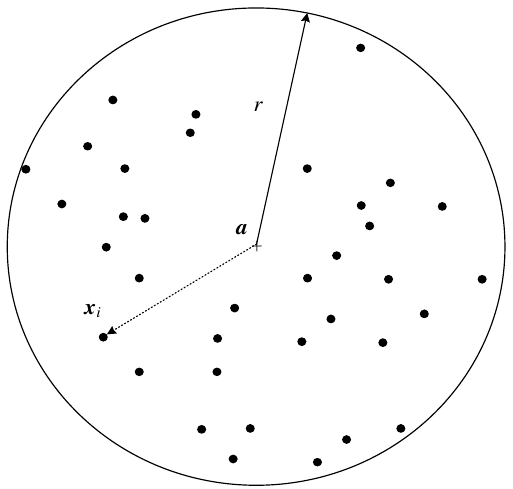
Figure 3. Schematic of the DSAE network. The first AE is in red, and the second AE is in green. Their position in the DSAE can also be color–coded.